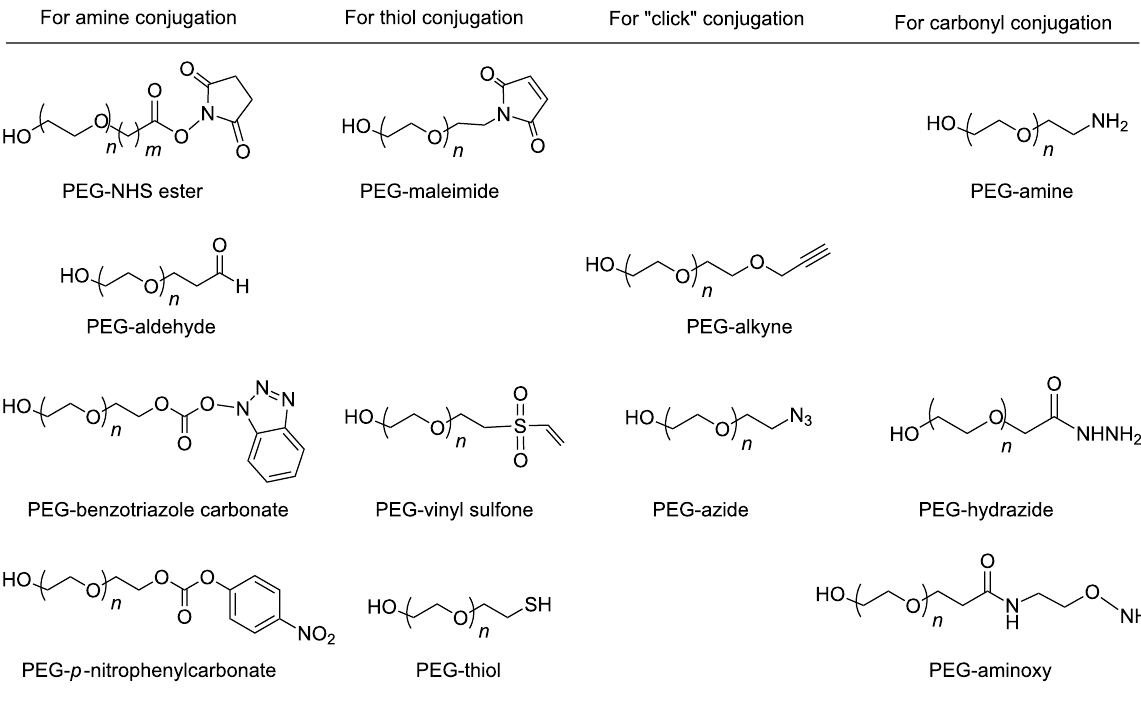
amino acid using N -hydroxysuccinimidyl (NHS) activated PEGs or aldehyde PEGs. This conjugation leads to heteroge- neous products, depending on the number of lysine residues in the molecule. Random PEGylation may have undesired steric effects, shielding active sites in the protein or disrupting its tertiary structure